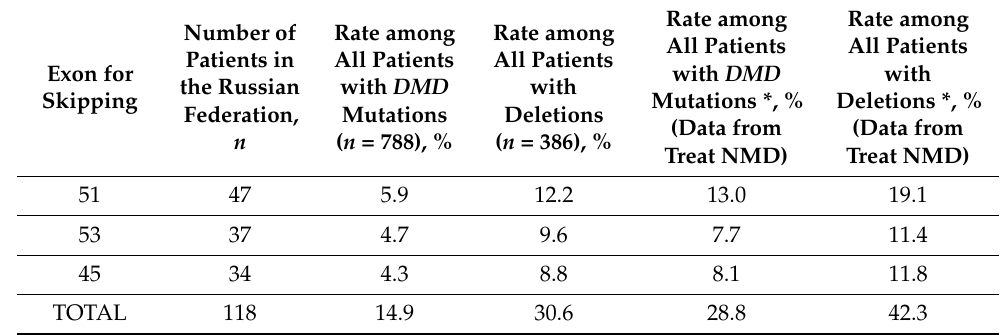
Table 3. Comparison of the numbers of patients eligible for exon skipping therapy in the Russian Federation and in the multi-ethnic